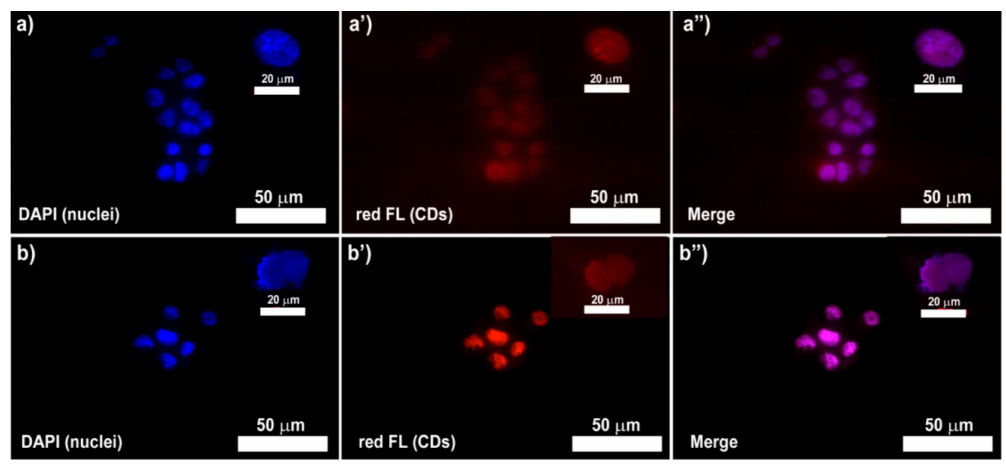
Figure 6. Uptake of PLGA-CDs20% NPs on human breast cancer cell culture (MDA-MB-231) after 6 h ( a – a” ) and 24 h ( b – b” ) of incubation. Magnification 40 × (insert: 100 × ).